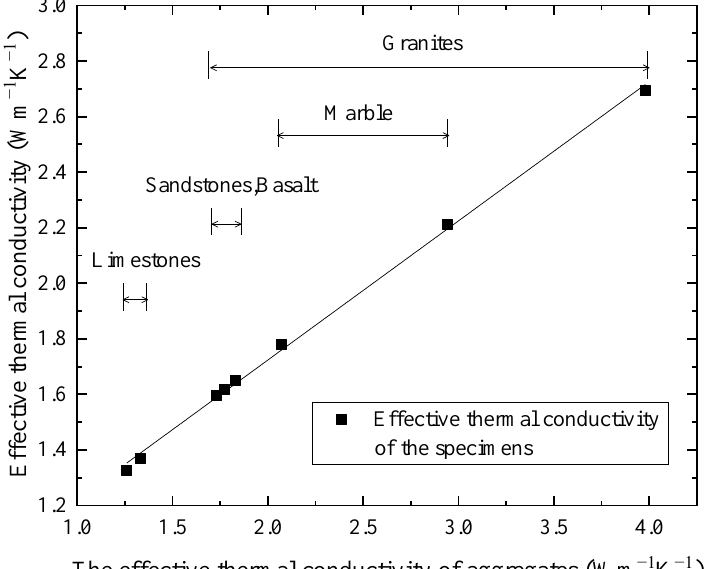
Figure 11. Effect of coarse aggregate type on asphalt concrete thermal conductivity.